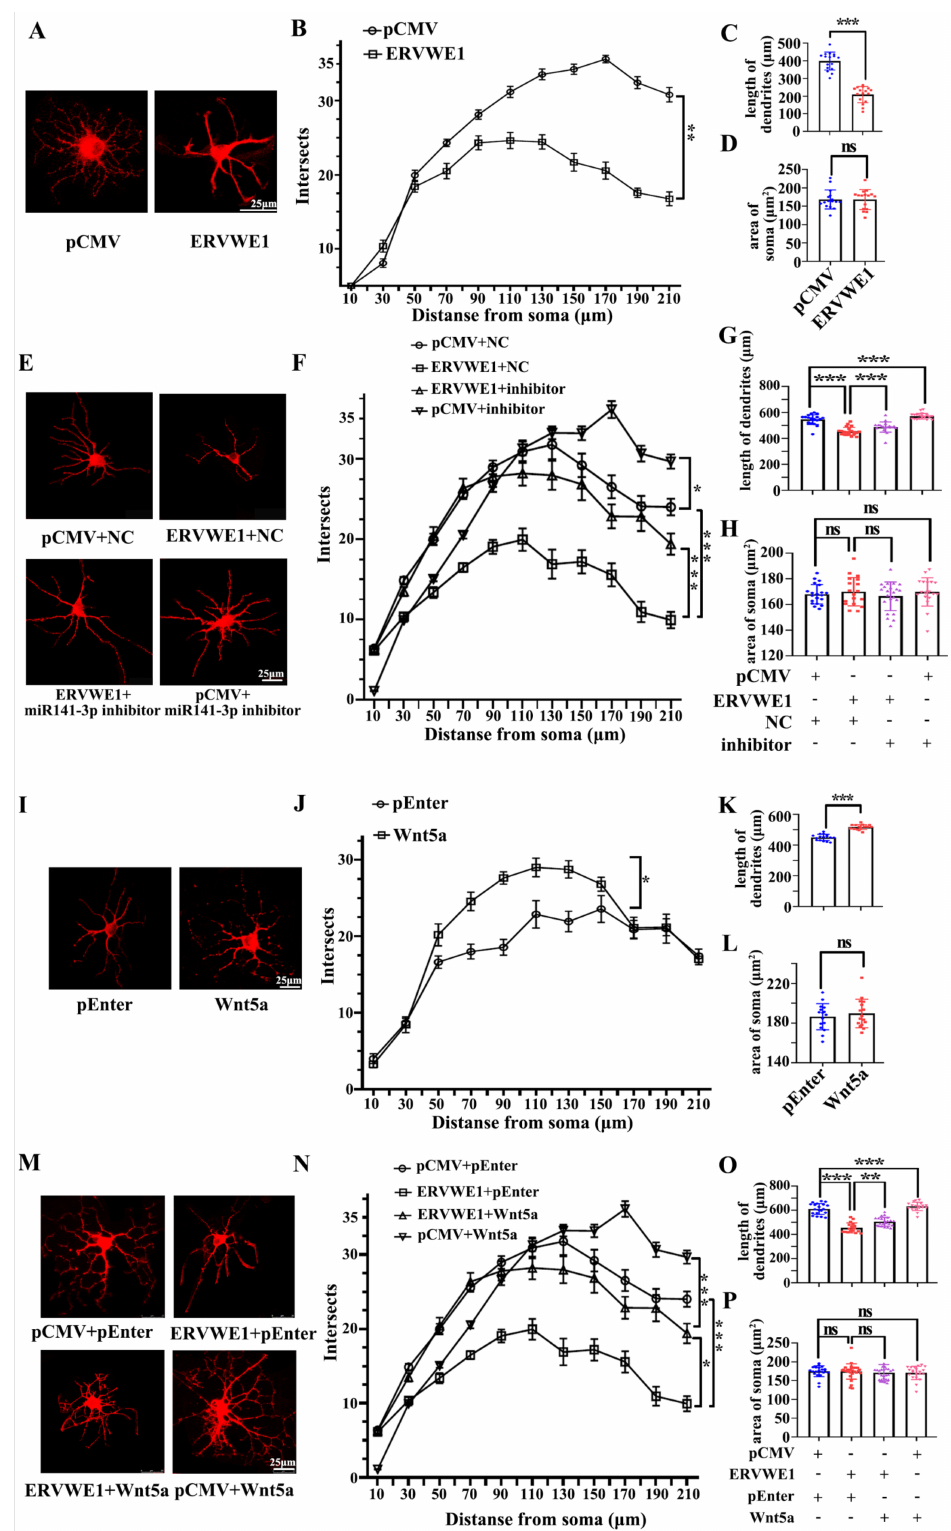
Figure 6. ERVWE1 changed the density of dendritic spine through miR-141-3p in rat hippocampal neurons. ( A , E , I , M ) Primary rat hippocampal neurons were transfected with ERVWE1, ERVWE1 and miR-141-3p inhibitor, Wnt5a, ERVWE1 and Wnt5a, then imaged at DIV14 and were immunostained with MAP2. High-magnification images were obtained by confocal microscopy. ( B , F , J , N ) The sholl analysis of dendrites from rat hippocampal neurons. ( C , G , K , O ) The total length of dendrites was measured by ImageJ software. ( D , H , L , P ) The soma area was measured by ImageJ software. *** p < 0.001, ** p < 0.01, * p < 0.05, ns: p >